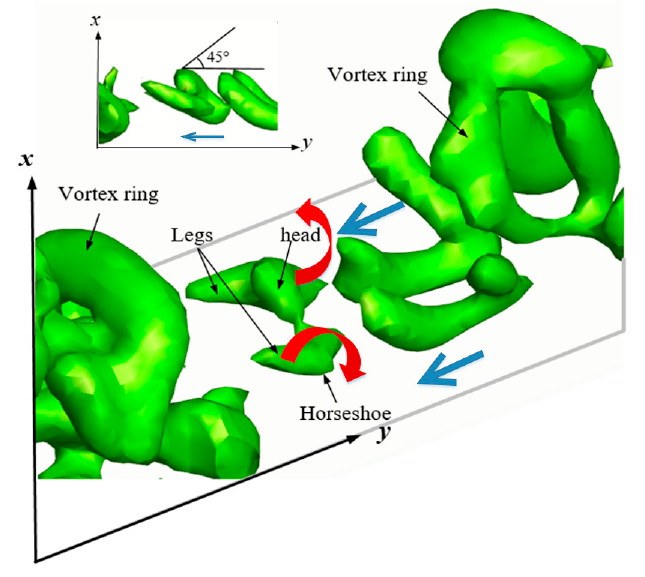
Figure 9. Structures of the “horseshoe” vortex near the narrow wall of the mold.